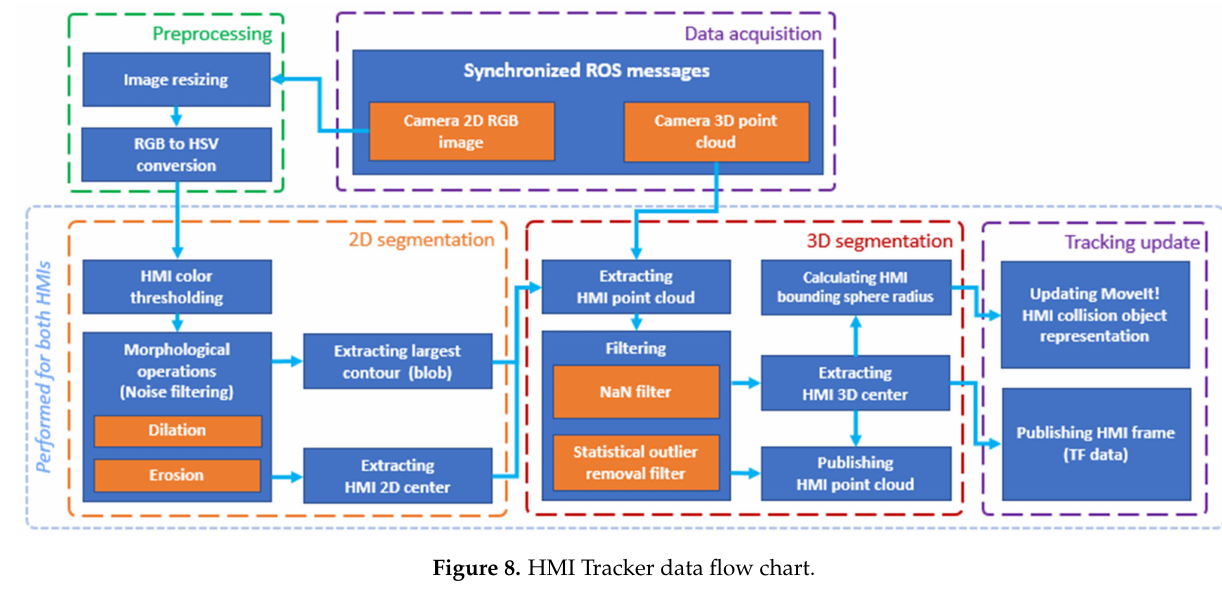
Figure 8. HMI Tracker data flow chart.